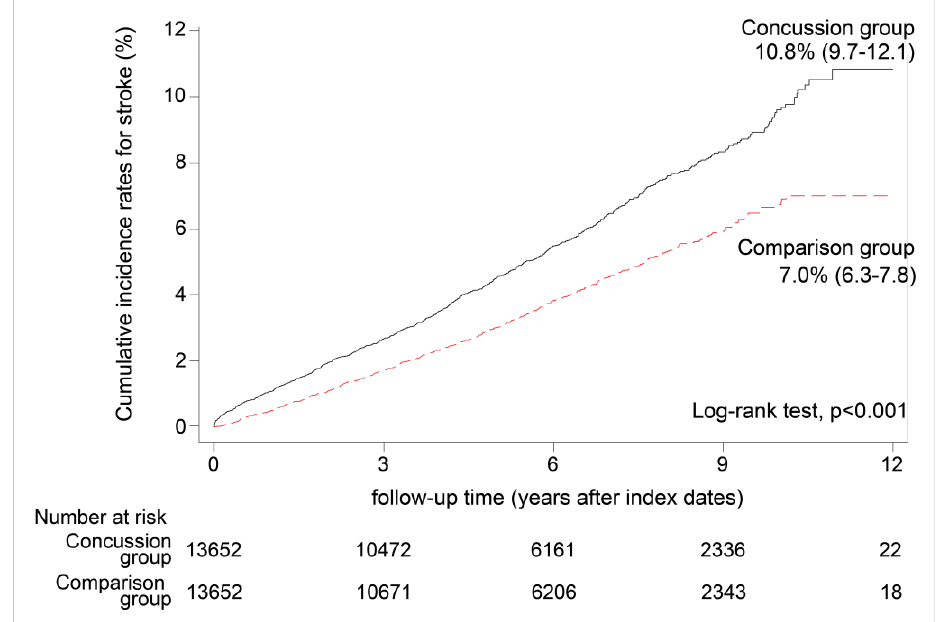
Figure 2. Cumulative incidence rates for stroke in the concussion group and comparison group ( n = 27,304, 1998–2005).